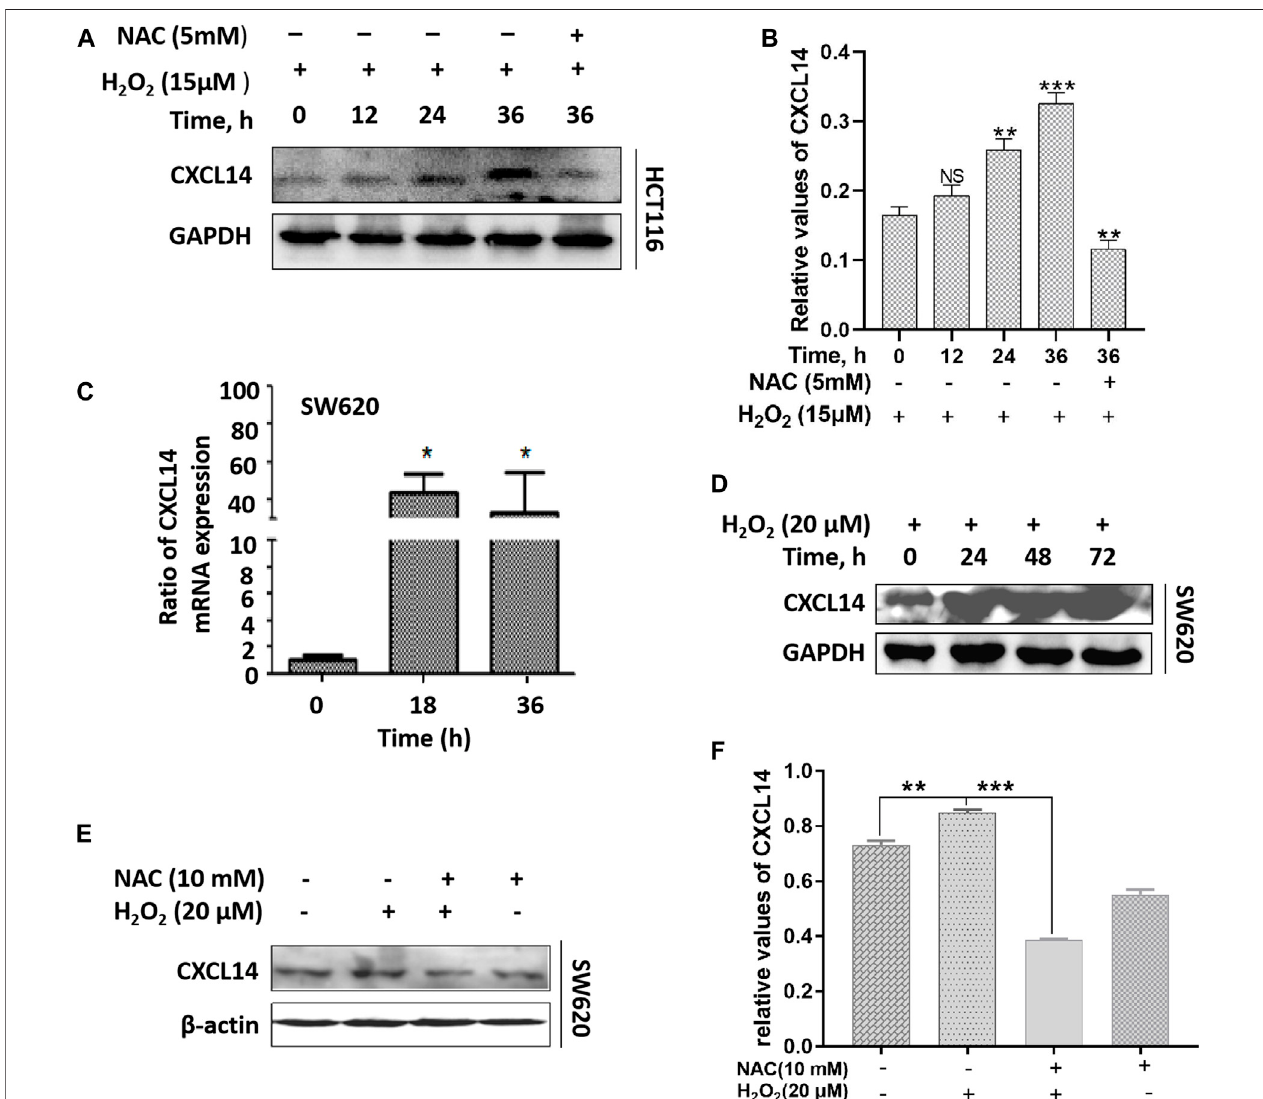
FIGURE4| ROSup-regulatedtheexpression ofchemokine CXCL14. (A) TheHCT116cellsweretreatedwith15 μ mol/LH2O2fordifferenttimeand/orpretreated with 5 mmol/L NAC. (B) Quantitative results of the expression levels of CXCL14. (C) The SW620 cells were treated with 20 μ mol/L H2O2 for different time. The expression level of CXCL14 mRNA was measured by real-time PCR. (D) The SW620 cells were treated with 20 μ mol/L H2O2 for different time. The expression level of CXCL14 protein was measured by western blot. (E) The SW620 cells were treated with 20 μ mol/L H2O2 and/or pretreated with 10 mmol/L NAC. (F) Quantitative results of the expression levels of CXCL14. All experiments were repeated three times or more. Error bars represent ± S.D. p < 0.05 was considered to be statistically signi fi cant. * p < 0.05; ** p < 0.01, *** p < 0.001.